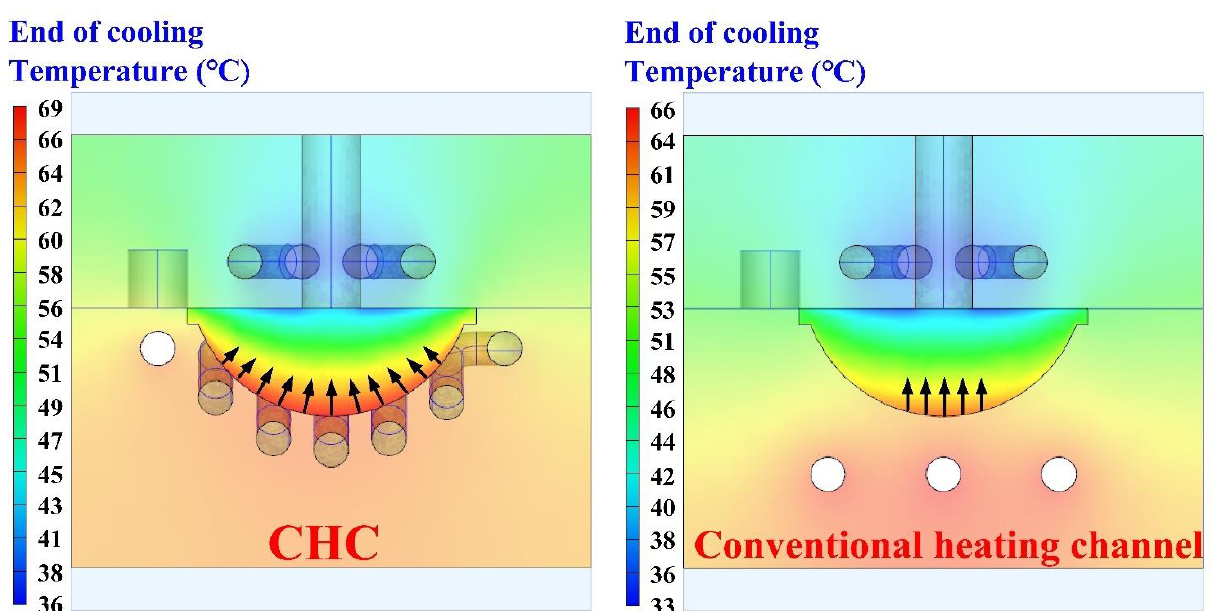
Figure 13. Vulcanization mechanism of a convex lens fabricated by LSR injection mold with ( a ) con- ventional heating channel and ( b ) CHC.